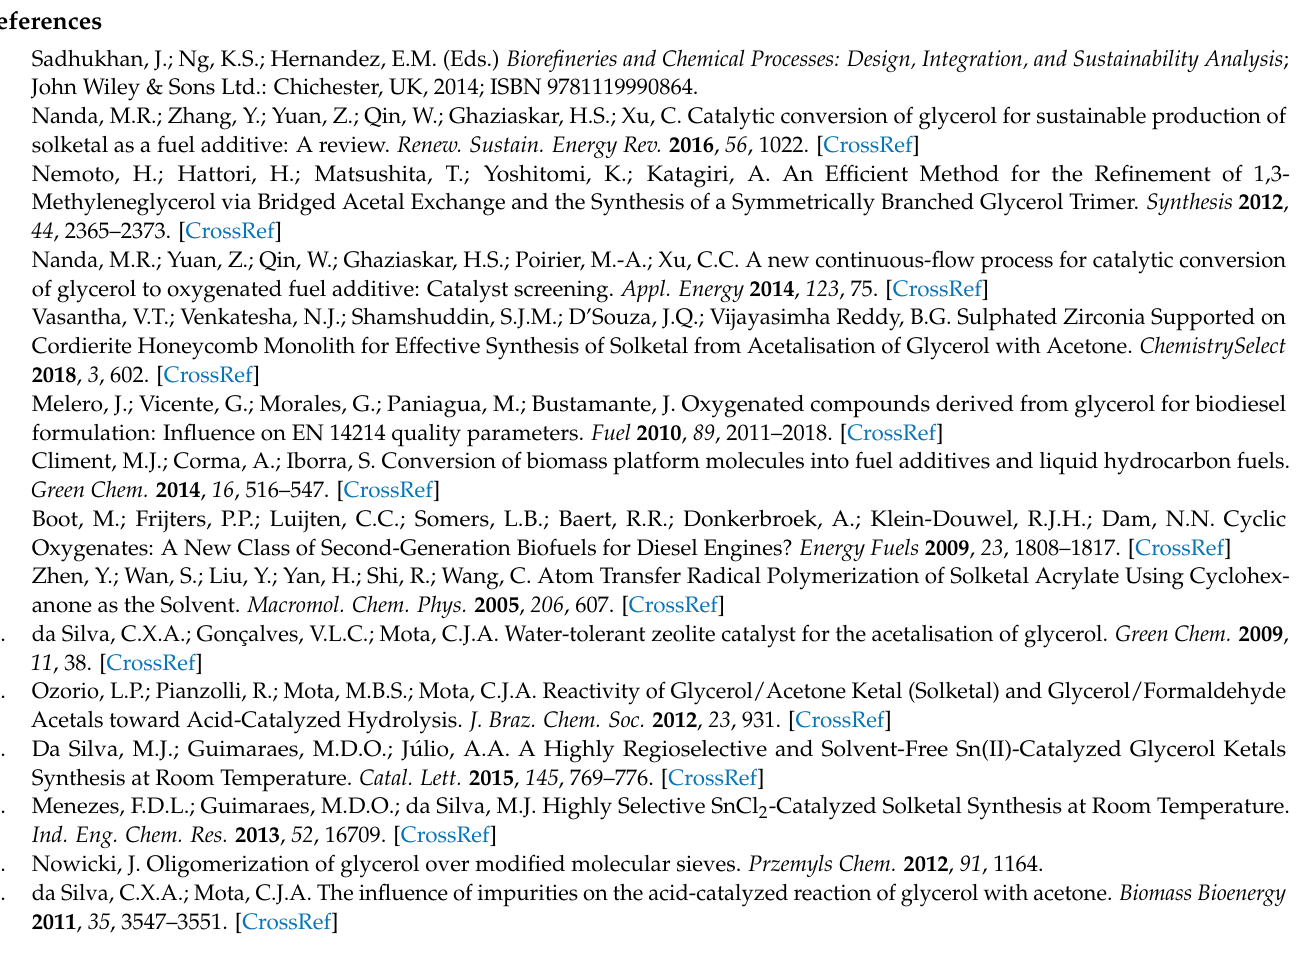
Figure S4: Catalyst regeneration cycle, Figure S5: Performance of regenerated